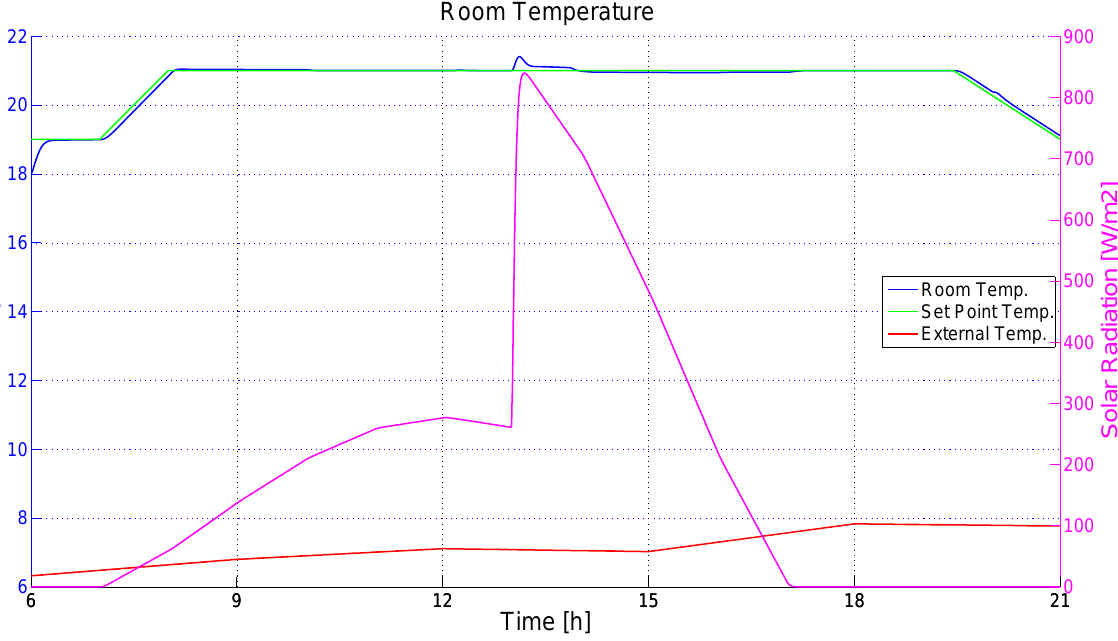
Figure 33. Control results (second scenario, modified control system, Energy Saving policy): room temperature (CV), outside temperature, and solar radiation (DVs).